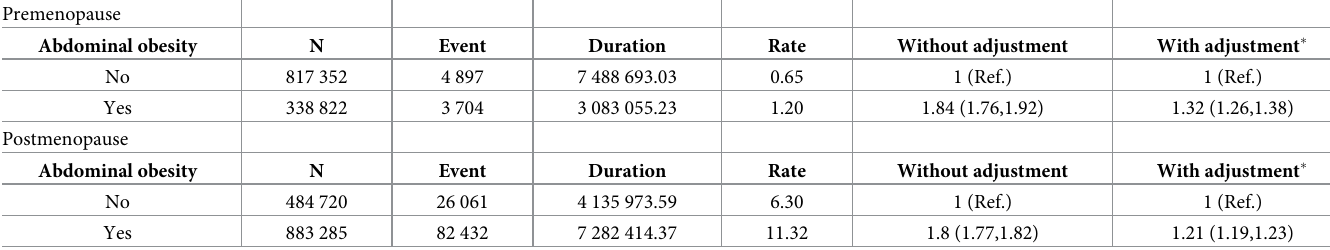
Table 4. Cox proportional hazards regression analysis for the development of vertebral fracture according to abdominal obesity status based on waist-to-height ratio in the premenopausal and postmenopausal groups.